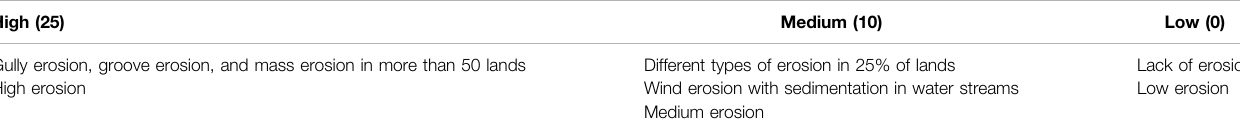
TABLE 4 | Determining the score related to the current status of erosion for sediment